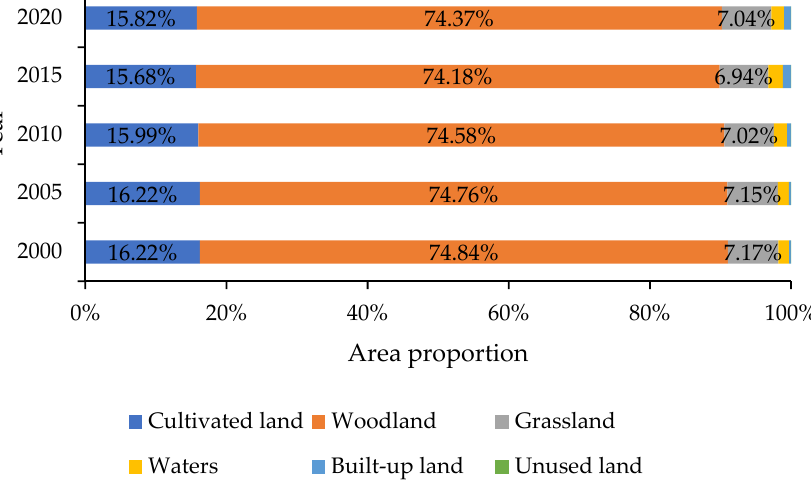
Figure 4. Area change percentage of land use types in Shiyan in different periods. 3.2. Spatiotemporal Variation Characteristics of Habitat Quality By running the habitat quality module of InVEST, the spatial distribution maps of habitat quality in Shiyan in 2000, 2005, 2010, 2015, and 2020 were obtained. On the grid layer, the habitat quality index is a value that varies continuously from 0 to 1. The closer the value is to 1, the better the habitat quality. The habitat is relatively complete and has a corresponding structure and function, which is conducive to maintaining biodiversity. In order to describe the evolution law of habitat quality in the study area more accurately, the habitat quality was divided into four levels using the natural breakpoint method in ArcGIS, namely I (very bad), II (bad), III (good), and IV (excellent), and the corresponding habitat quality index value ranges were 0.0–0.4, 0.4–0.6, 0.6–0.8, and 0.8–1.0, respectively. In terms of spatial distribution (Figure 5), the habitat quality of the entire city was high in the northwest and southwest, moderate in the center, and low in the northeast.